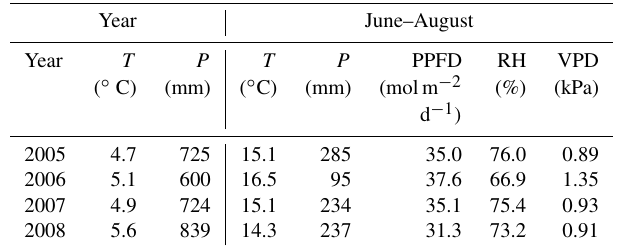
Table 1. Meteorological parameters for the full years and summer months, June–August. T = mean air temperature, P = precipitation sum, PPFD = mean daily sum of photosynthetic photon flux den- sity, RH = mean relative humidity, VPD = mean vapour pressure deficit in the afternoon (12:00–16:00